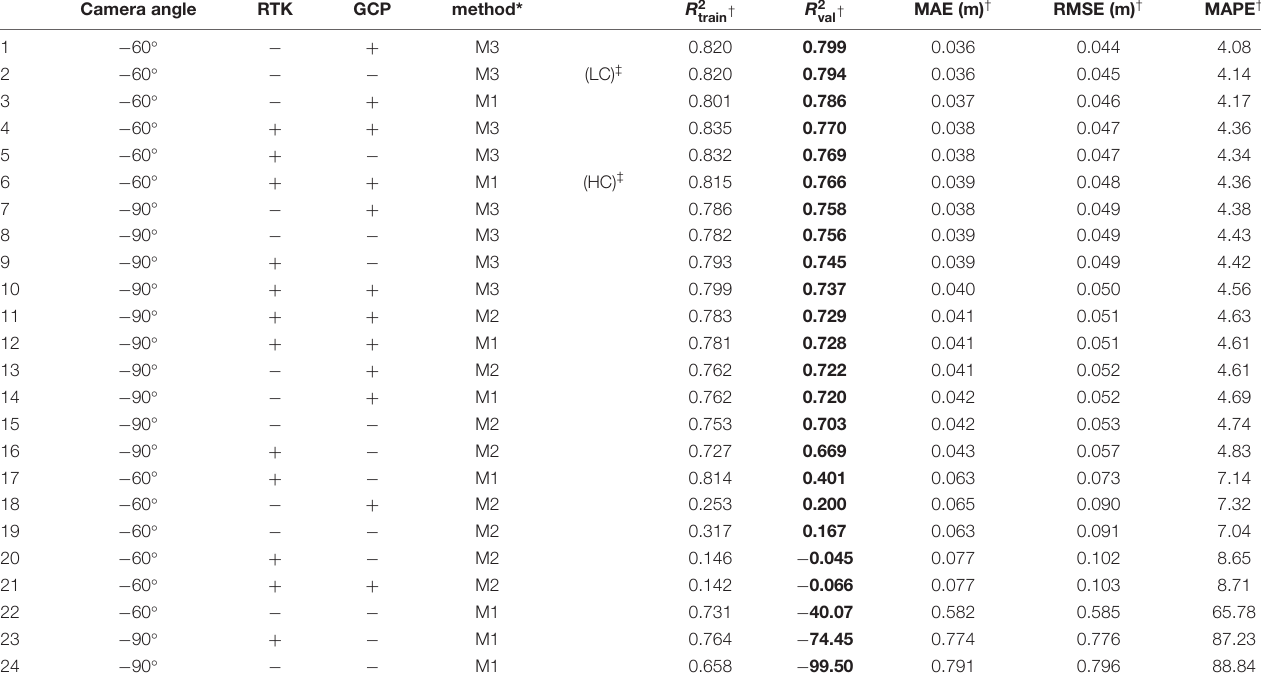
TABLE 7 | Evaluation metrics on cross-validation of PH regression models in the vegetative stage of Field 2. Camera angle RTK GCP method*